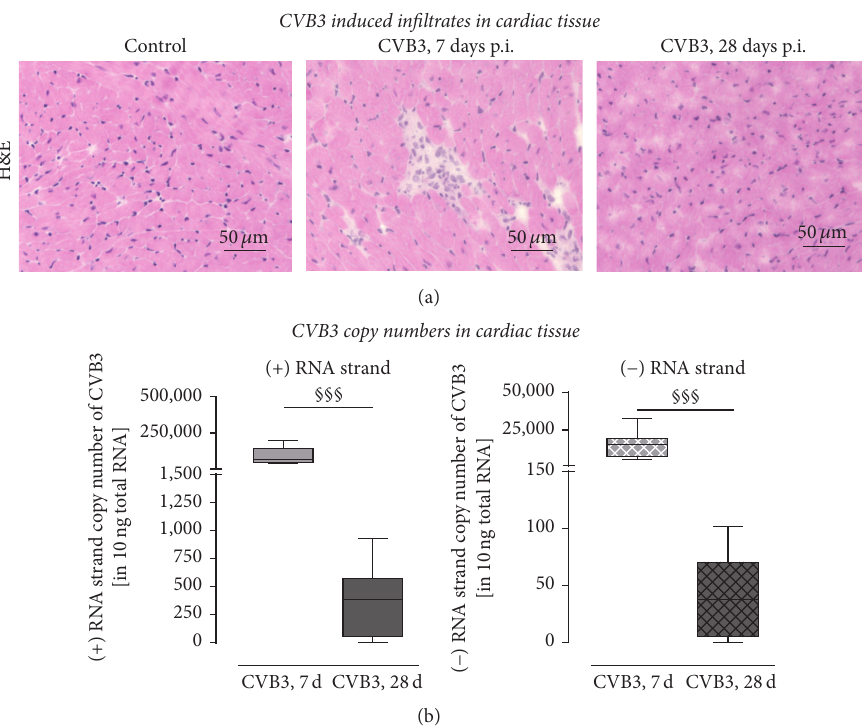
Figure 1: Cardiac inflammation and viral load in C57BL/6J mice 7 and 28 days after CVB3 infection. (a) Hematoxylin/eosin staining of cardiac tissue revealed higher numbers of invaded inflammatory cells 7 days after infection compared to control tissue. However, 28 days after infection inflammatory cells are hardly detectable and thus remarkably reduced compared to 7 days after infection. (b) Viral load in cardiac tissue of CVB3-infected C57BL/6J mice after 7 and 28 days. To determine the amount of progeny positive-strand RNA or the intermediate negative-strand RNA of CVB3, cDNA synthesis was performed with (+) or ( − ) strand-specific primers followed by quantification. More (+) RNA than ( − ) RNA was detected in cardiac tissue 7 as well as 28 days after infection. The amount of both strands was clearly reduced between 7 and 28 days demonstrating the elimination of CVB3 virus particles as well as the elimination of infected cells. However, the (+) RNA strand was detected in a higher extent compared to the ( − ) RNA strand; § significantly different compared to 7 days p.i.; §§§ 𝑃 < 0.001